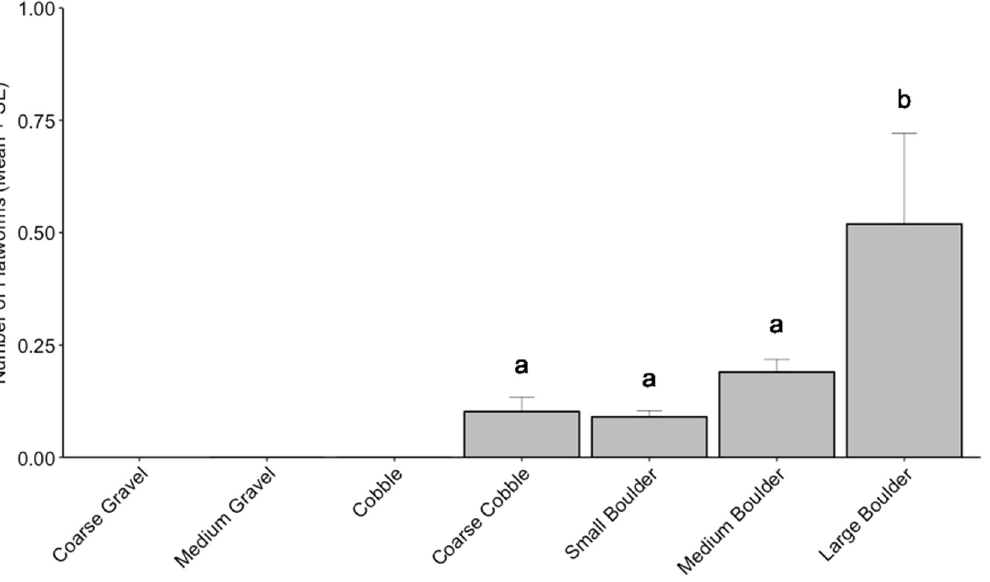
Figure 5. Average (+SE) number of flatworms under each rock size pooled across all boulder beaches. Differences in lower case letters indicate significant difference in flatworm abundance.